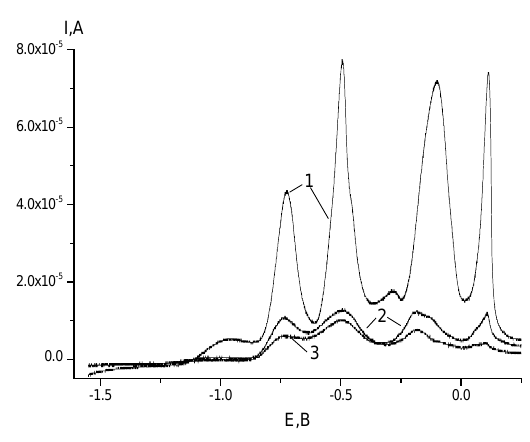
Fig. 2. Stripping voltammograms: Effect of tear fluid on the test system. (1) test system, (2) tear fluid, and (3) tear fluid after instillation of